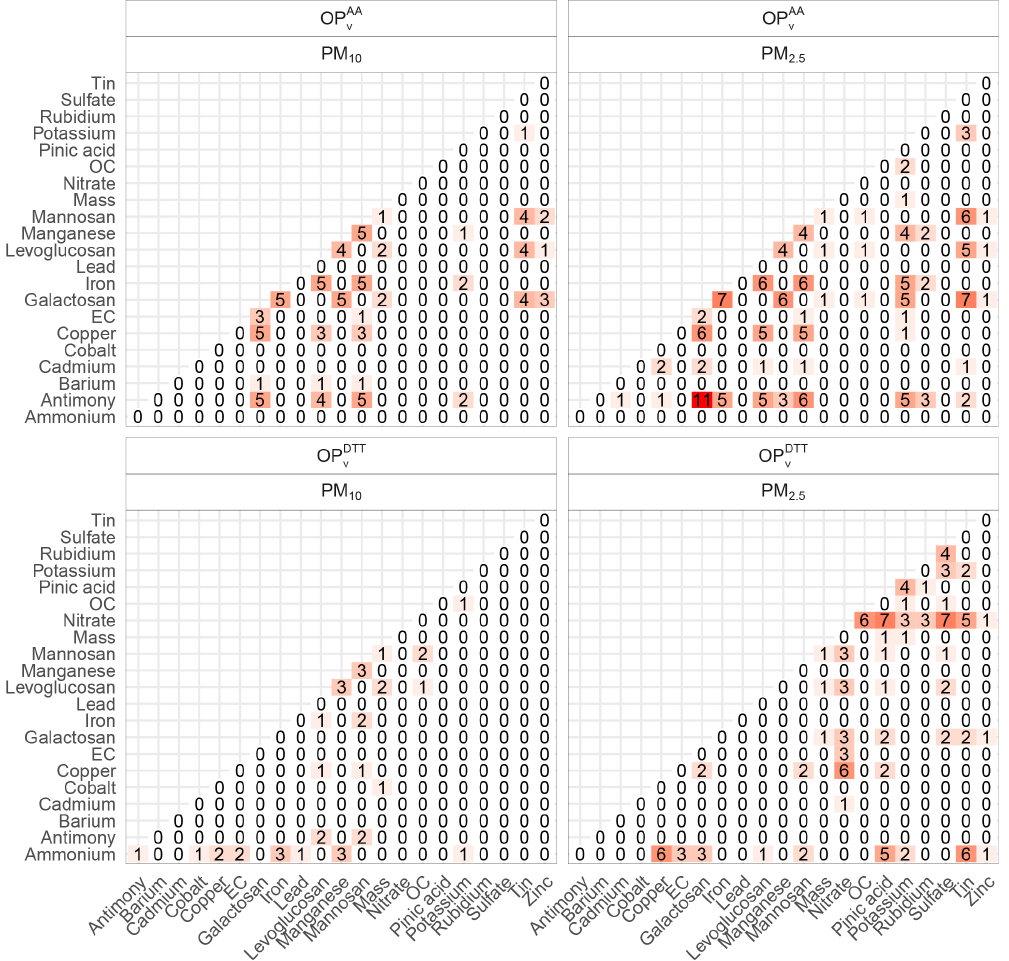
Figure 7. Number of times that a combination of two independent variables for the filtered models was present for PM 10 and PM 2 . 5 and two OP v assays for five sampling